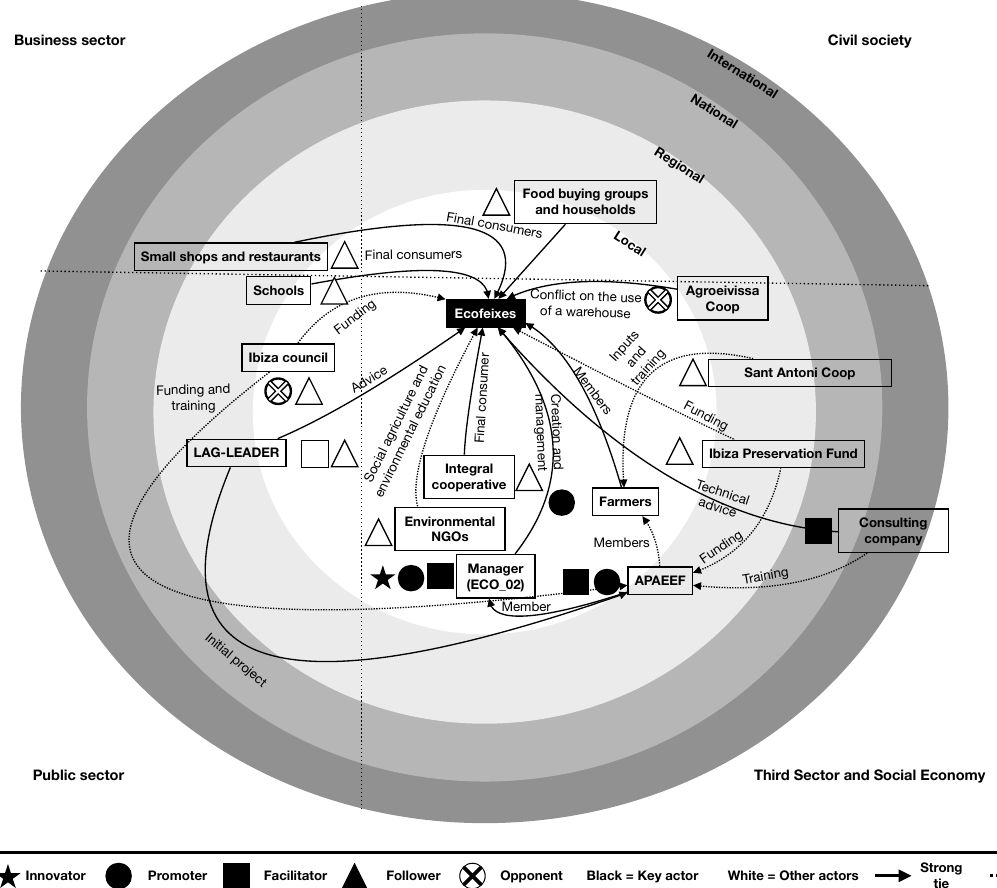
Figure 2. Actors involved in Ecofeixes by role, scale and sector. Own elaboration based on the qualitative analysis of primary data (1st